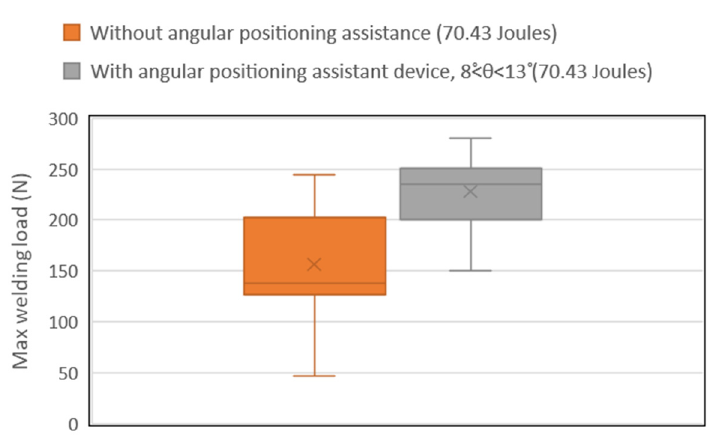
Figure 9. Distribution of maximum loads of point welds with and without the aid of an angular positioning device.